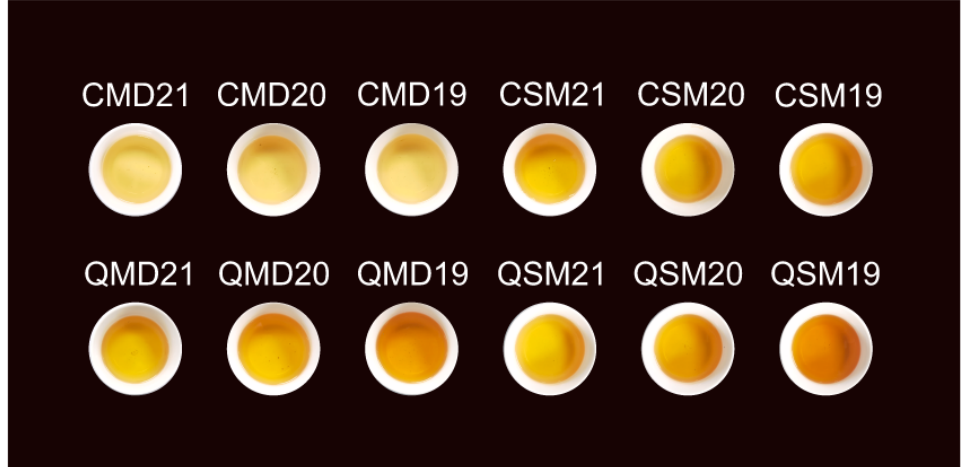
Figure 1. The tea infusions of SPWTs and APWTs leaves. White teas picked in spring were called SPWTs and those picked in autumn were called APWTs. White peony teas and Shou Mei picked in spring were termed CMD19-21 and CSM19-21, respectively, while those picked in autumn were correspondingly named QMD19-21 and QSM19-21. The number following CMD, QMD, CSM, and QSM represented the production years, corresponding to 2019, 2020, and 2021, respectively (Table